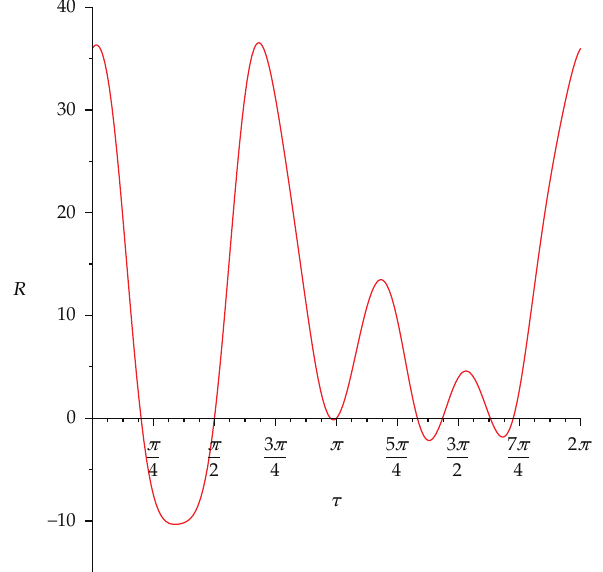
Figure 7: The evolution of the R with respect of the cosmic time τ for (cid:2) 3.13 (cid:3) .